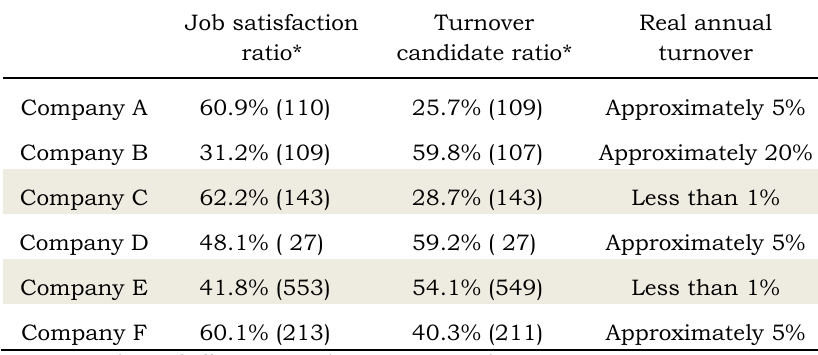
Table 1. Real annual turnover Job